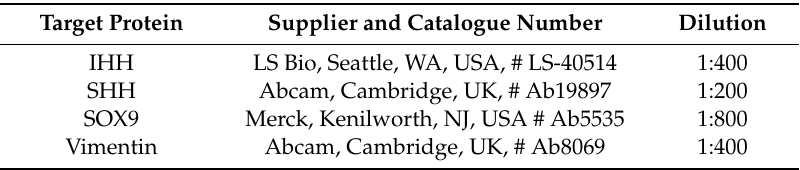
Table 2. Primary antibodies and incubation